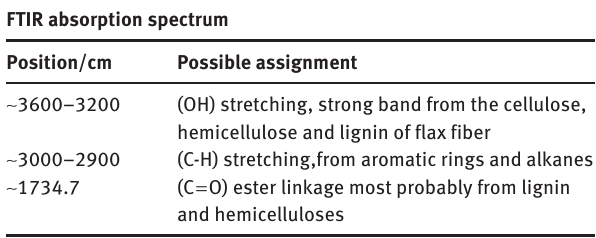
Table 1: Possible assumption of FTIR absorption